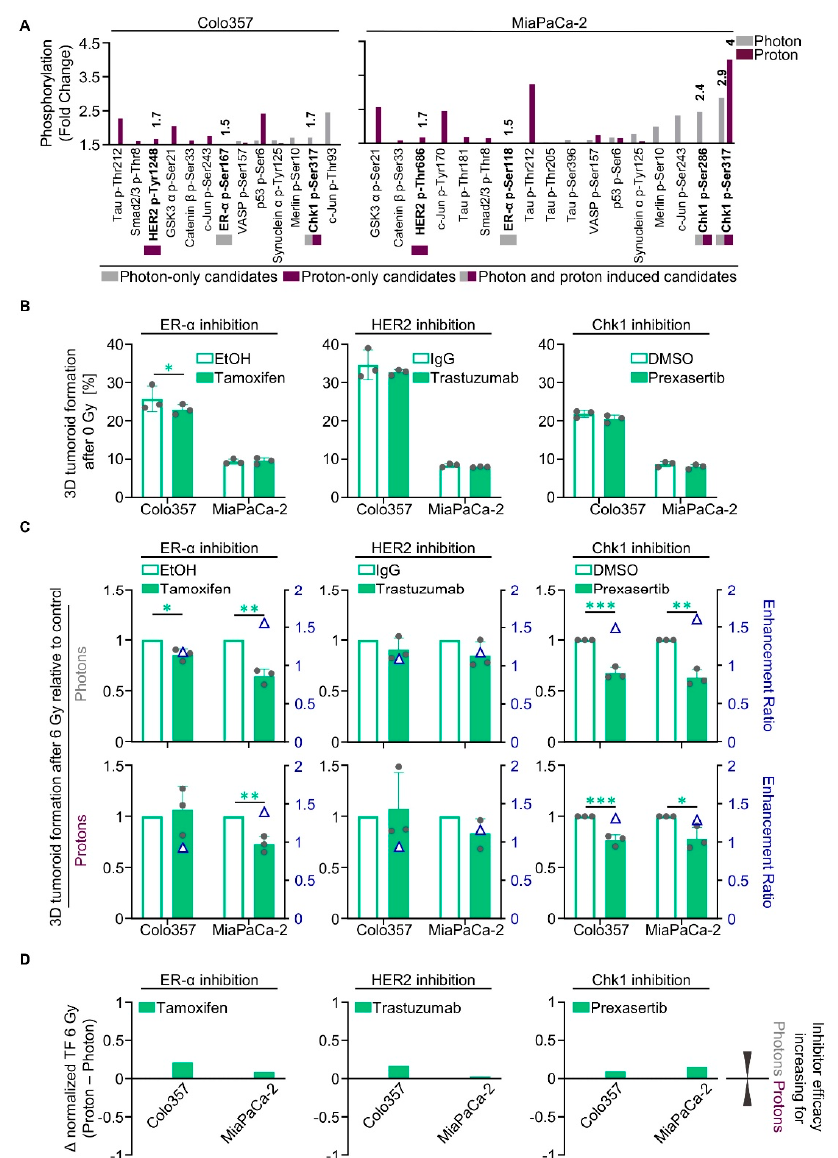
Figure 3. Photon- and proton-irradiated 3D PDAC cell cultures differentially respond to tamoxifen, trastuzumab and prexasertib. ( A ) Phospho-site alterations with ≥ 50% increase in phosphorylation (fold change; displayed data start at 1.5) in 6-Gy photon- or proton-irradiated Colo357 and MiaPaCa-2; ( B ) 3D tumoroid formation capacity of unirradiated Colo357 and MiaPaCa-2 cells treated with tamoxifen, trastuzumab or prexasertib (experimental set-up shown in Figure S2A); ( C ) Normalized 3D tumoroid formation capacity upon 1-h pretreatment with tamoxifen, trastuzumab or prexasertib in combination with 6-Gy photon or proton irradiation. Enhancement ratio (tumoroid formation capacity after 6 Gy control treatment/tumoroid formation capacity after 6 Gy inhibitor treatment) are indicated as blue triangles; ( D ) Differences in the radiosensitizing efficacy of inhibitors visualized by Δ values of normalized tumor formation capacity (tumoroid formation capacity after 6 Gy of protons - tumoroid formation capacity after 6 Gy of photons). All results show mean ± SD ( n = 3; two-sided t -test; *, p < 0.05; **, p < 0.01; ***, p < 0.001); Δ : delta, TF: tumoroid formation.